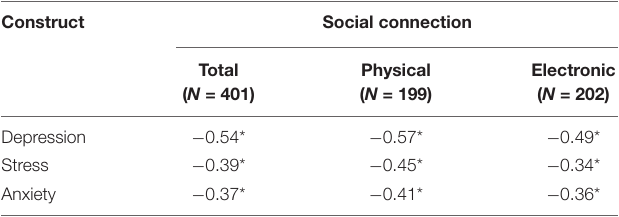
TABLE 2 | Correlations between social connection and mental health.